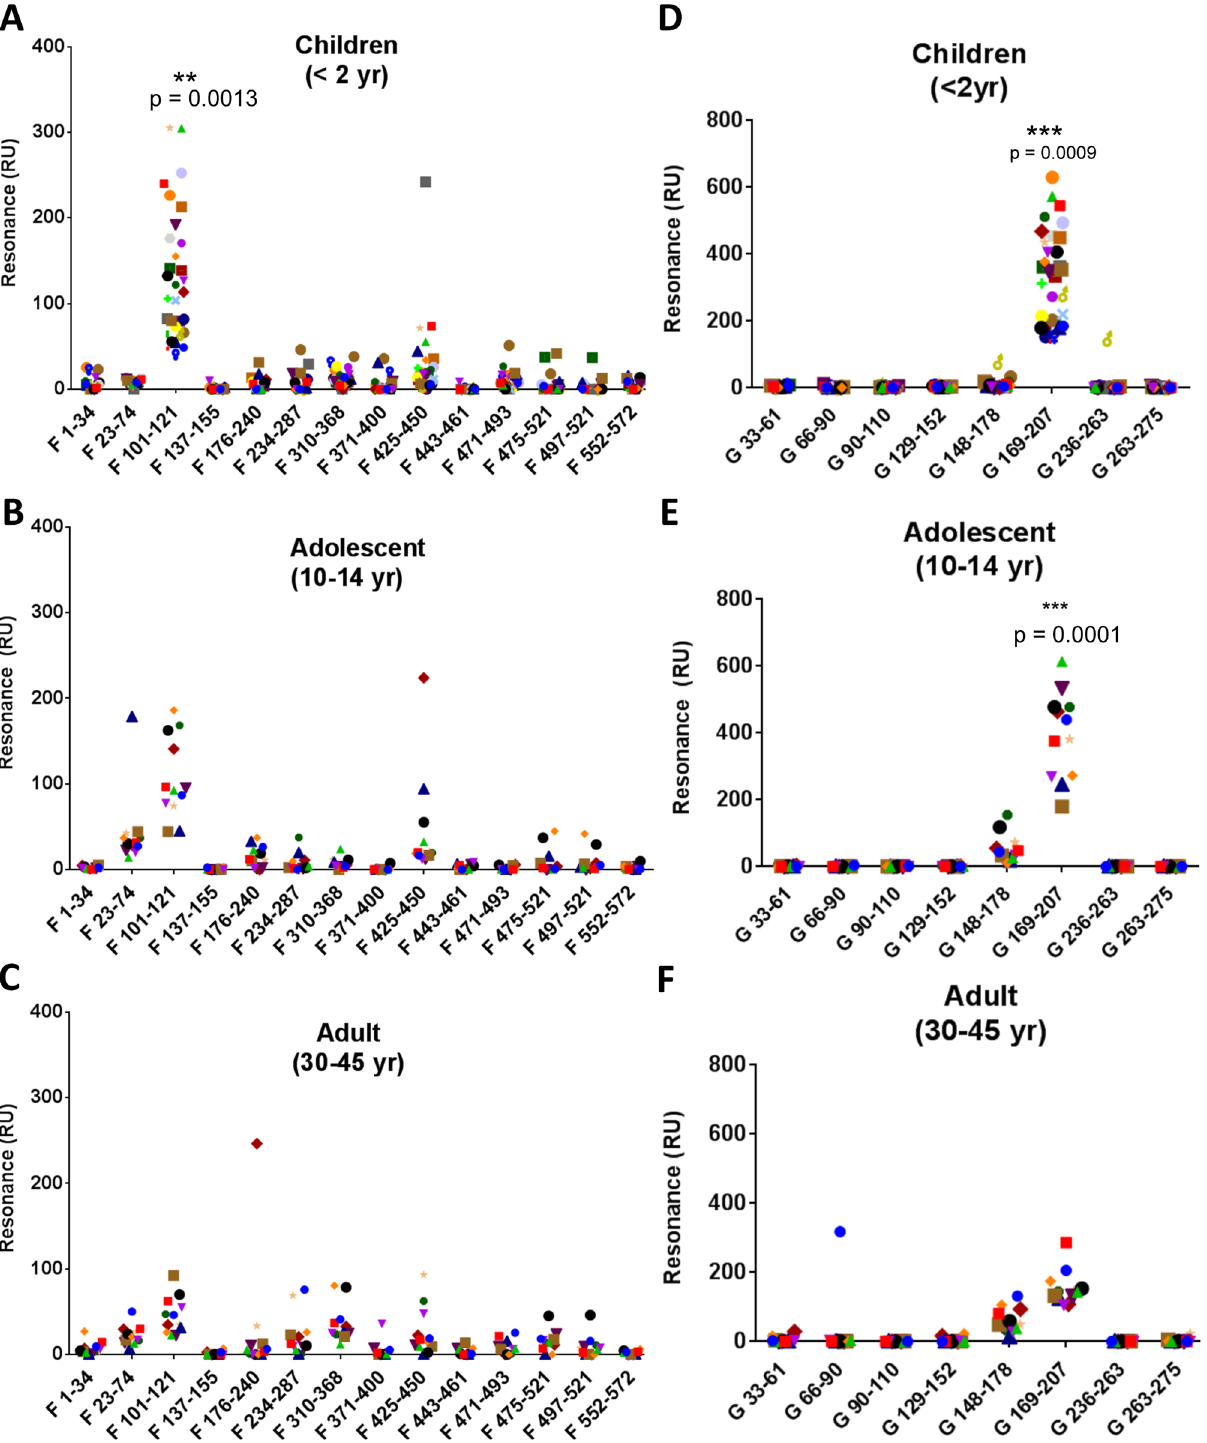
Fig 5. Surface plasmon resonance (SPR) analysis of human sera from of different age group for binding to peptides from different antigenic sites within RSV-F and RSV-G. Selected peptides of RSV-F and G proteins representing the antigenic sites in Figs 2 and 4 were chemically synthesized and tested for binding against individual sera samples using real time SPR kinetics experiment. Total antibody binding is represented as SPR resonance units (RU). Panels A-C show total antibody binding against the F peptides and panels D-F show total antibody binding to G peptides with serum/plasma samples from children less than 2 years old (A and D), adolescents; 10 – 14 years old (B and E) and adults 30 – 45 years old (C and F). Peptides in the X-axis are